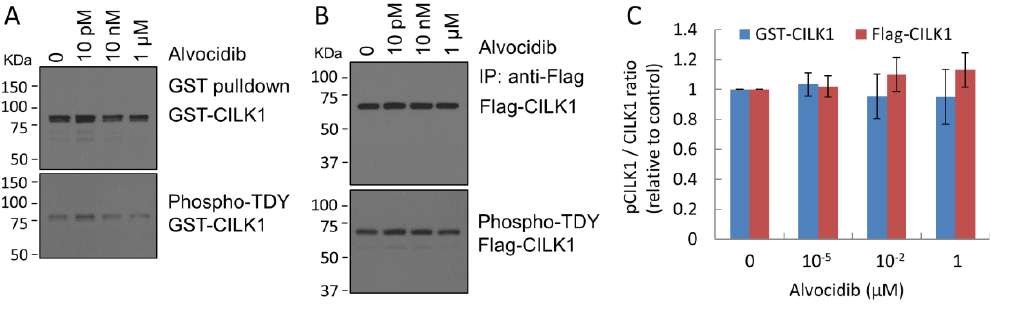
Figure 2. Alvocidib effect on TDY phosphorylation in CILK1. ( A , B ) HEK293T cells transfected with either GST ‐ CILK1 or Flag ‐ CILK1 were treated with Alvocidib or DMSO control. After GST pull ‐ down or anti ‐ Flag immunoprecipitation, total and phospho ‐ TDY signals of CILK1 were detected by Western blotting with antibodies recognizing CILK1 and phospho ‐ TDY motif, respectively. ( C ) The phospho ‐ TDY and total CILK1 ratio relative to the DMSO control against different concentrations of Alvocidib is shown as average ± SD, n = 3; Student t ‐ test, not significant.